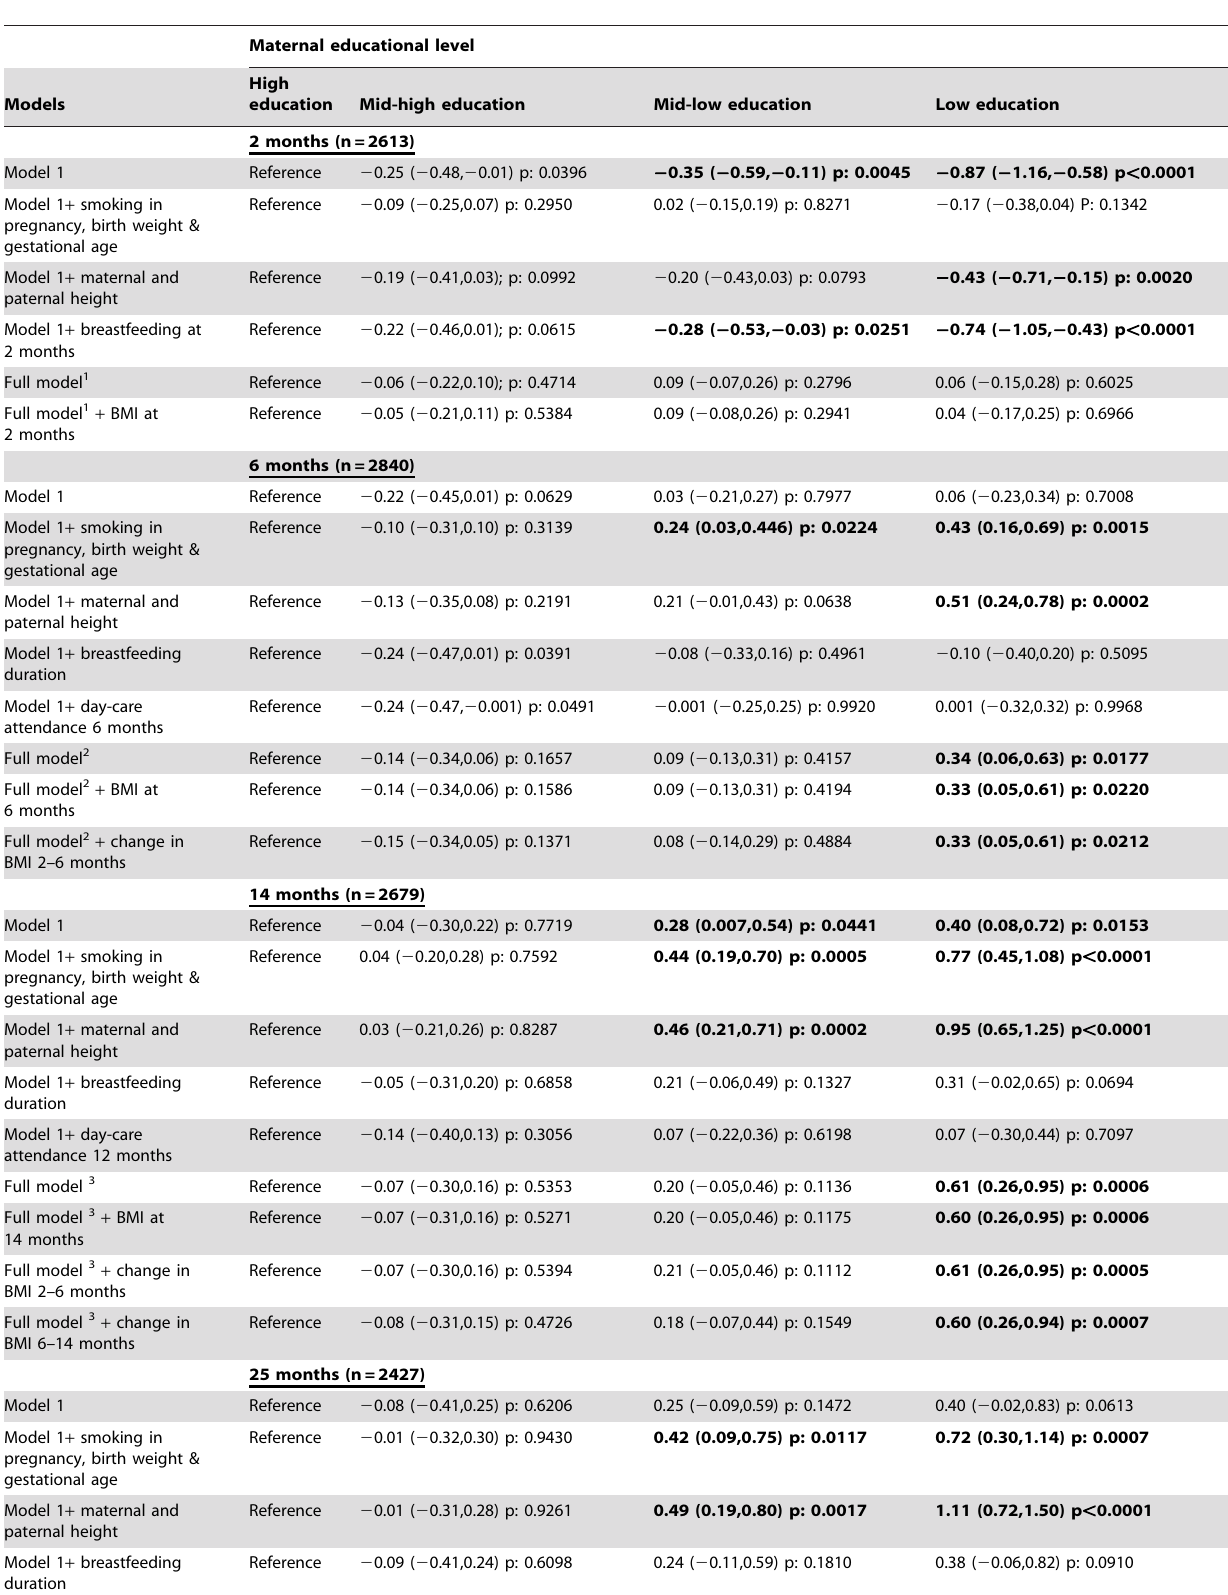
Table 2. Differences in child’s height at 2, 6, 14 and 25 months of age between maternal educational